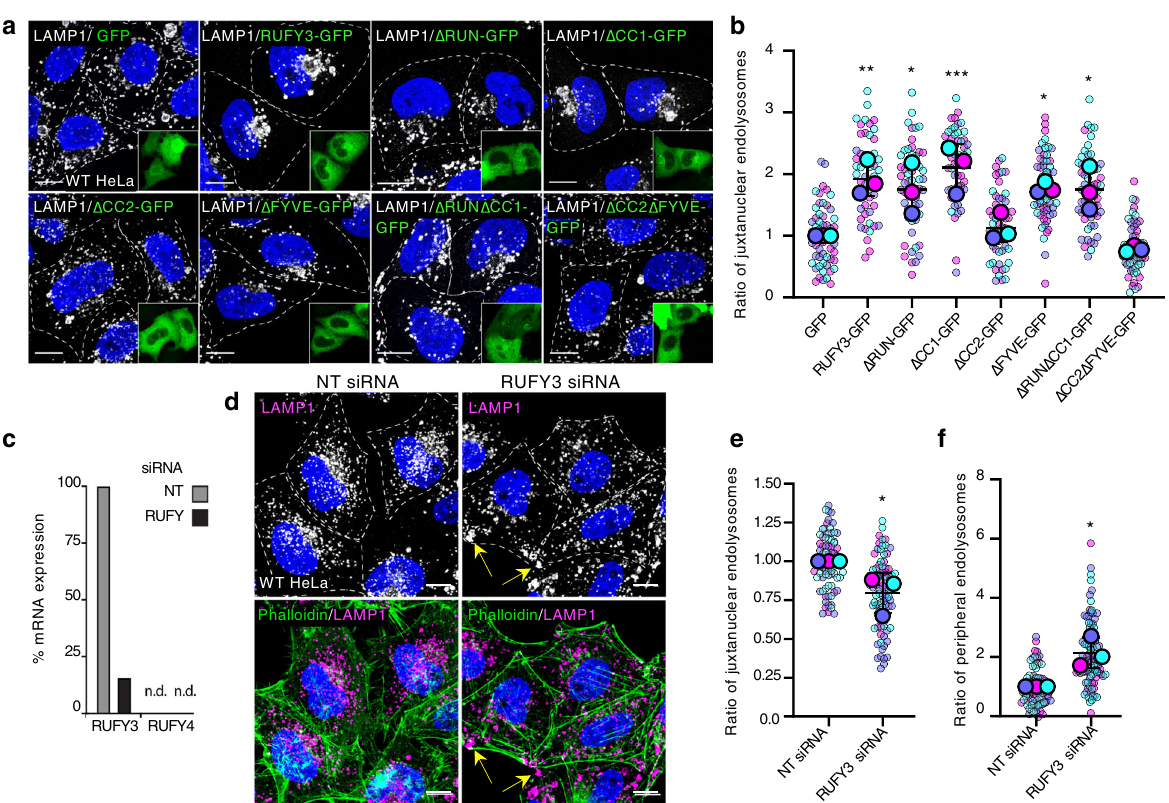
Fig. 5 Effects of overexpressing RUFY3 deletion constructs or knocking down RUFY3 on the distribution of endolysosomes. a Immuno fl uorescence microscopy of HeLa cells transfected with plasmids encoding GFP (control) or RUFY3-GFP deletion constructs depicted in Fig. 2c (green in the insets), fi xed and immunostained for endogenous LAMP1 (grayscale). Nuclei were stained with DAPI (blue). Highly overexpressing cells were chosen for analysis, thus the strong cytosolic fl uorescence of the constructs in the insets. Cell edges are highlighted with dashed lines. Scale bars: 10 μ m. Insets show 2.85-fold reductions of the transfected cells. b SuperPlot representation as described for Fig. 3c, h of the effect of RUFY3-GFP deletion constructs on the distribution of LAMP1 from experiments such as that shown in panel ( a ). Horizontal lines represent the mean ± SD of the means from three independent experiments. Statistical signi fi cance was calculated using one-way ANOVA with multiple comparisons to GFP using Dunnett ’ s test. * p < 0.05, ** p < 0.01, *** p < 0.001. c qRT-PCR of RUFY3 and RUFY4 mRNA relative to actin mRNA in HeLa cells treated with non-targeting (NT) or RUFY3/4 SMARTpool siRNAs. n.d., not detected. d Immuno fl uorescence microscopy of HeLa cells treated with non-targeting (NT) or RUFY3 SMARTpool siRNA and stained with antibodies to endogenous LAMP1 (grayscale and magenta) and Alexa fl uor 546-conjugated phalloidin (green) to highlight cell edges. Nuclei were stained with DAPI (blue). Cell edges in grayscale images are highlighted with dashed lines. Yellow arrows indicate accumulation of endolysosomes at cell vertices. Scale bars: 10 μ m. e , f SuperPlot representation as described for Fig. 3c, h of the effect of RUFY3 KD on the juxtanuclear ( e ) and peripheral ( f ) distribution of LAMP1 from experiments such as that shown in panel ( d ). Horizontal lines indicate the mean ± SD of the means from three independent experiments. Statistical signi fi cance was calculated using the two-tailed unpaired Student ’ s t test. * p < 0.05. See also Supplementary Fig.